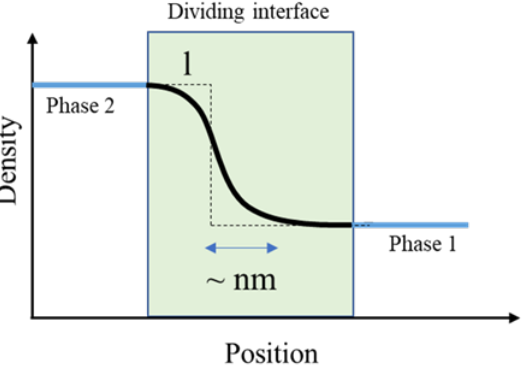
Figure 3. Schematic plot of the density ρ as a function of position x crossing the interface.